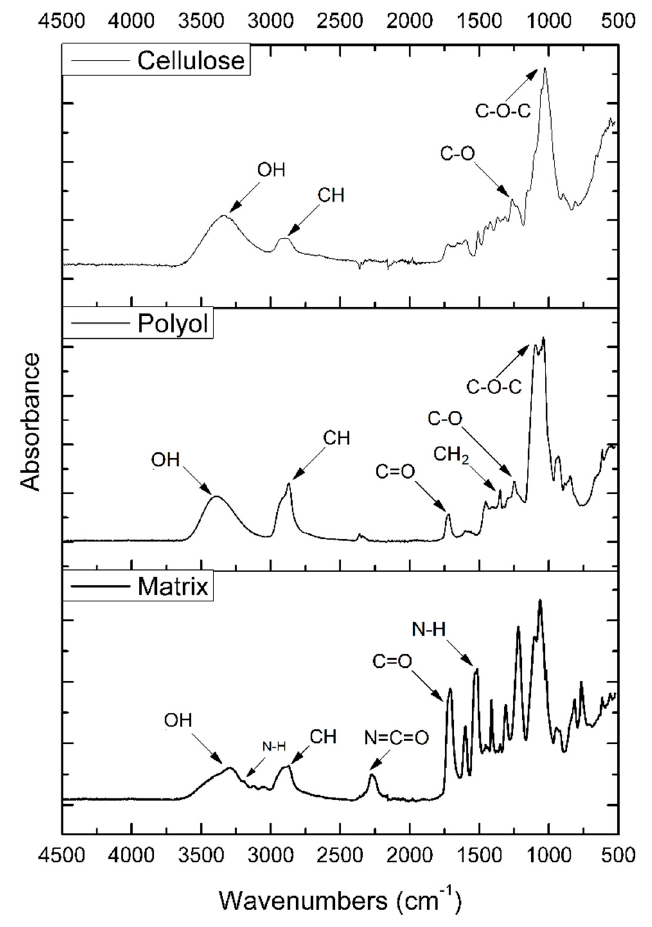
Figure 7. FT-IR spectra of biomass (cellulose), polyol and matrix.